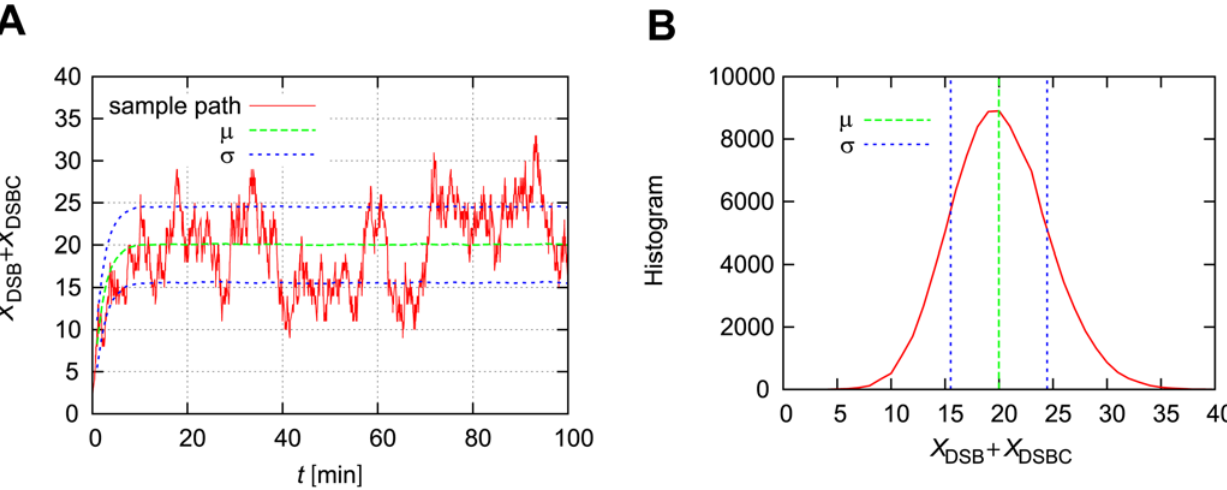
Figure 2. Simulation results of repair processes of DSBs. (A) A time course of the numbers of DSBs and DSBCs with the time-dependent expectation ( m ) and standard deviation ( s ). The blue lines denote m 6 s . (B) The histogram of the numbers of DSBs and DSBCs at time t =100[min]. In ~ 1000 . Other parameters are as defined in Table 1. Initial numbers of molecules are these figures, the maximum number of repair proteins X max RP X 0